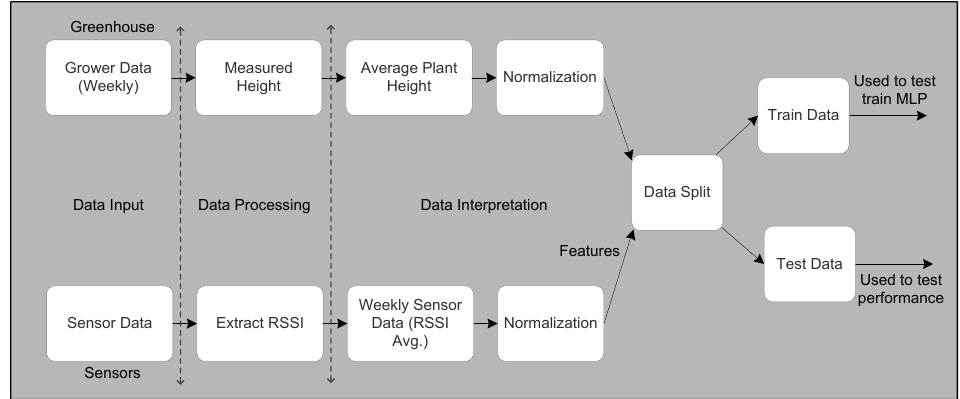
Figure 8. Data processing stages using inputs from sensors and greenhouse for MLP.